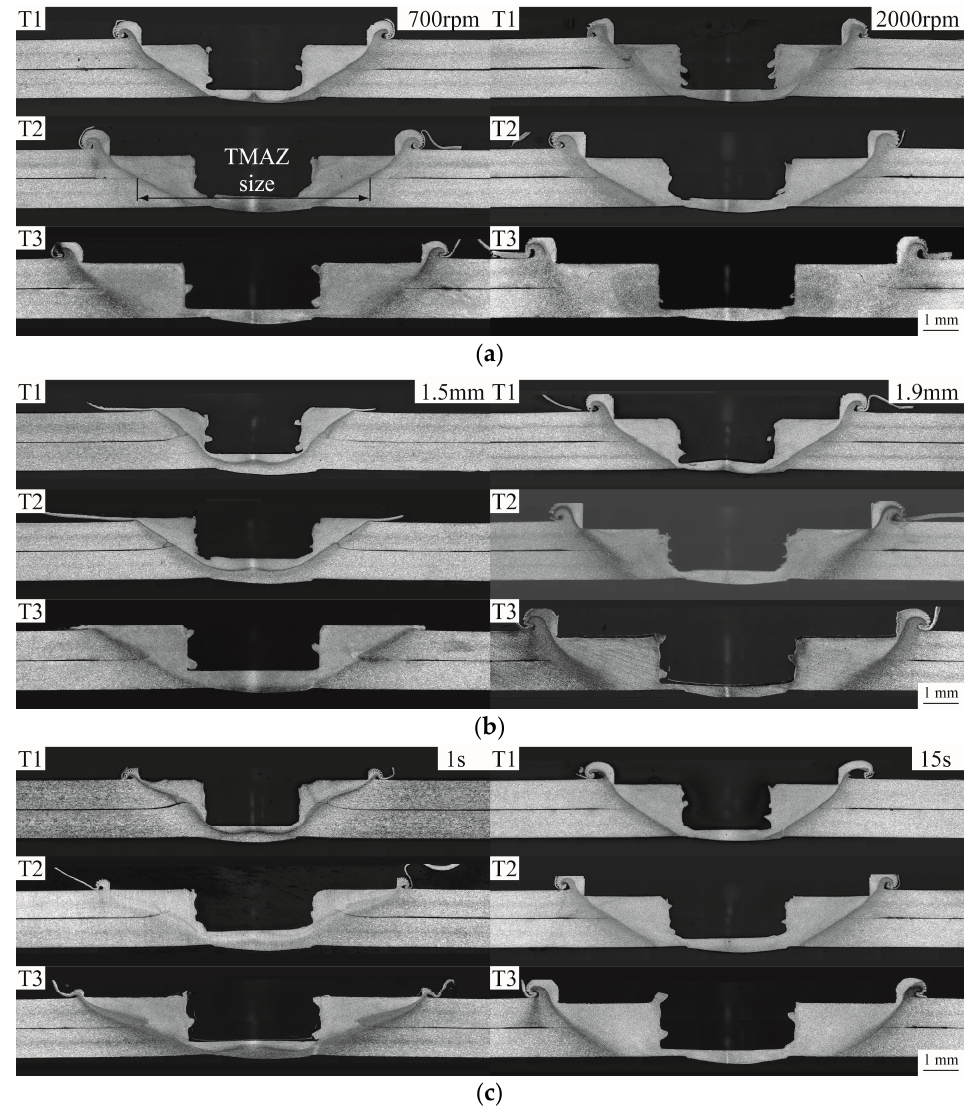
Figure 6. Optical micrographs of the cross sections of FSSWs made by the three weld tools at ( a ) rotational speeds of 700 and 2000 rpm; ( b ) indentation depths of 1.5 and 1.9 mm; and ( c ) dwelling times of 1 and 15 s.